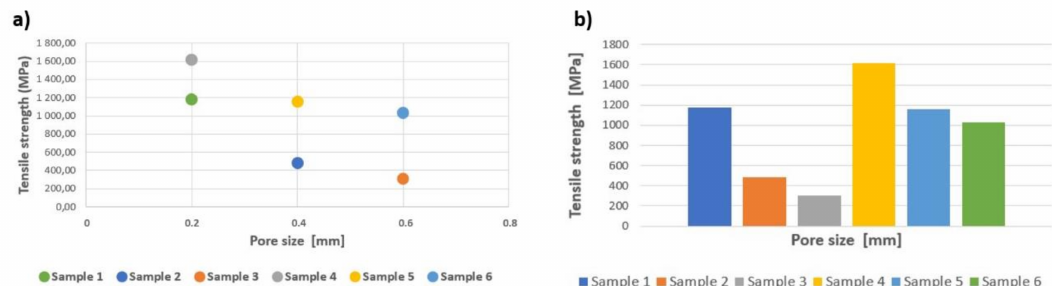
Figure 13. ( a ) Comparison of max. tensile strength with considering the pore size. ( b ) Average values of the maximum tensile strength of tested samples types 1–6.